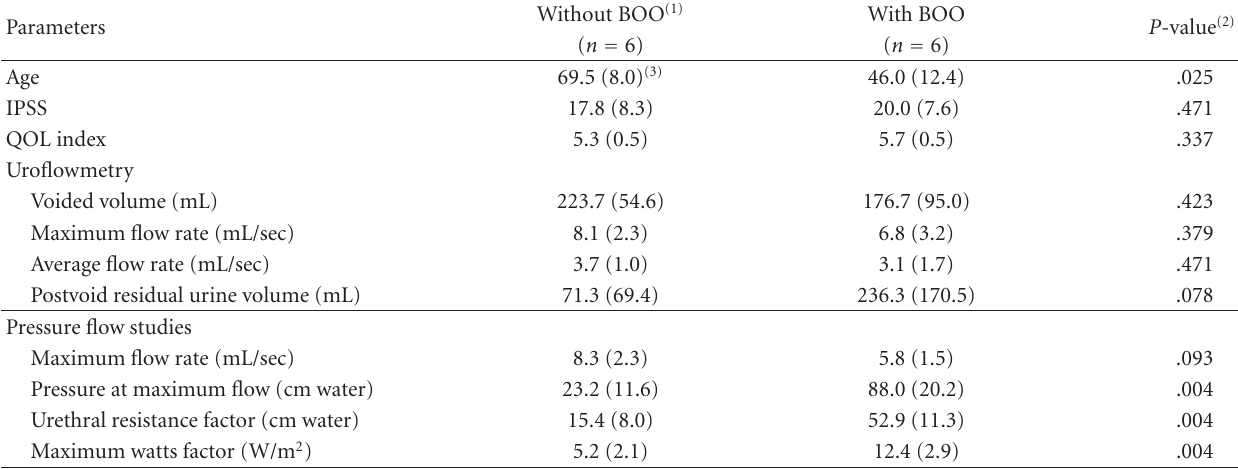
Table 1: Baseline parameters in patients with and without bladder outlet obstruction.